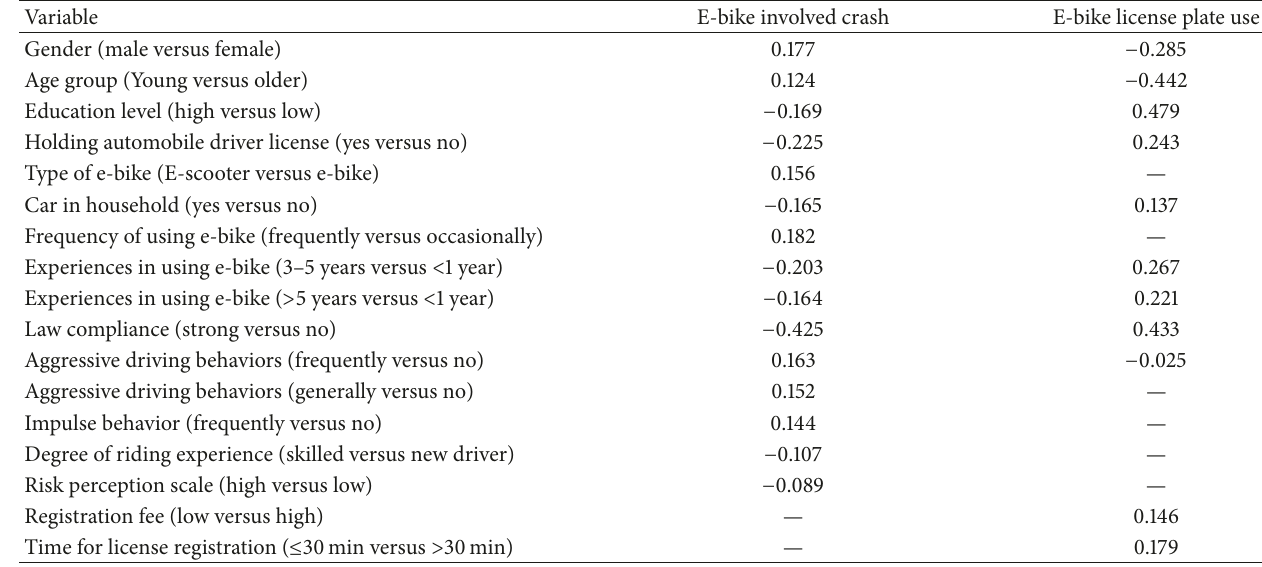
Table 6: Marginal effects for the BP